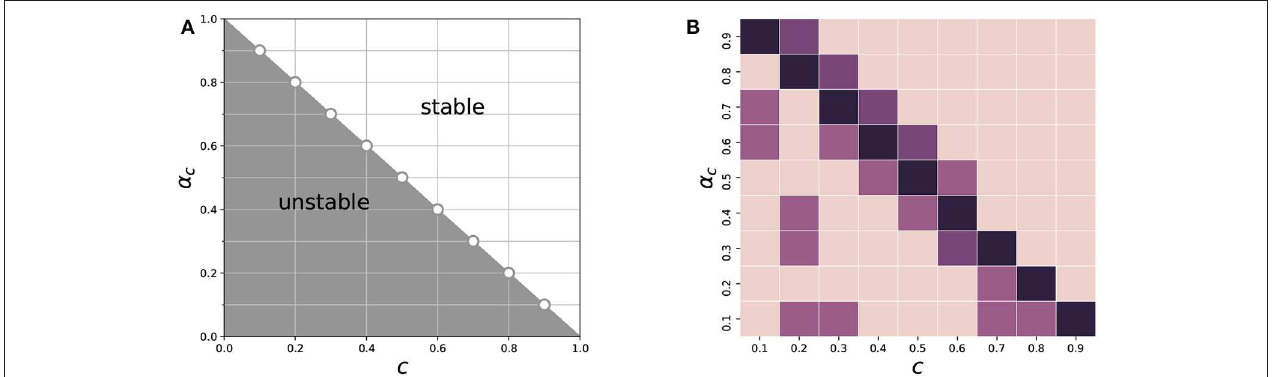
FIGURE 2 | The relationship between critical market confidence and price limit down. (A) Shows the phase transition boundary as α c = 1 − c , from which the system switches from stable to unstable. (B) Shows the ratios of initially shocked stock whose neighbors’ maximum α c from 0.1 to 0.9. The darker the higher of the ratios. The grids on diagnose are the darkest ones, indicating the majority of initial shocked stocks have at least one = 1 − c neighbor with α c i